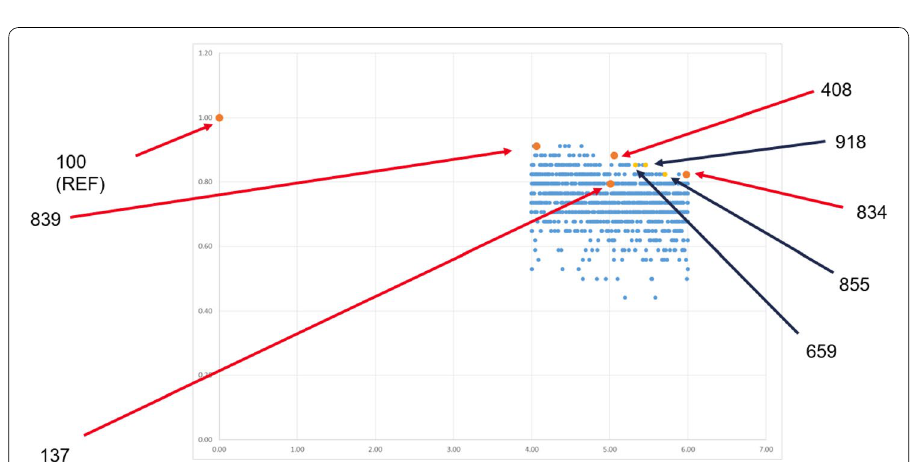
Fig. 6 ROM prediction on validation